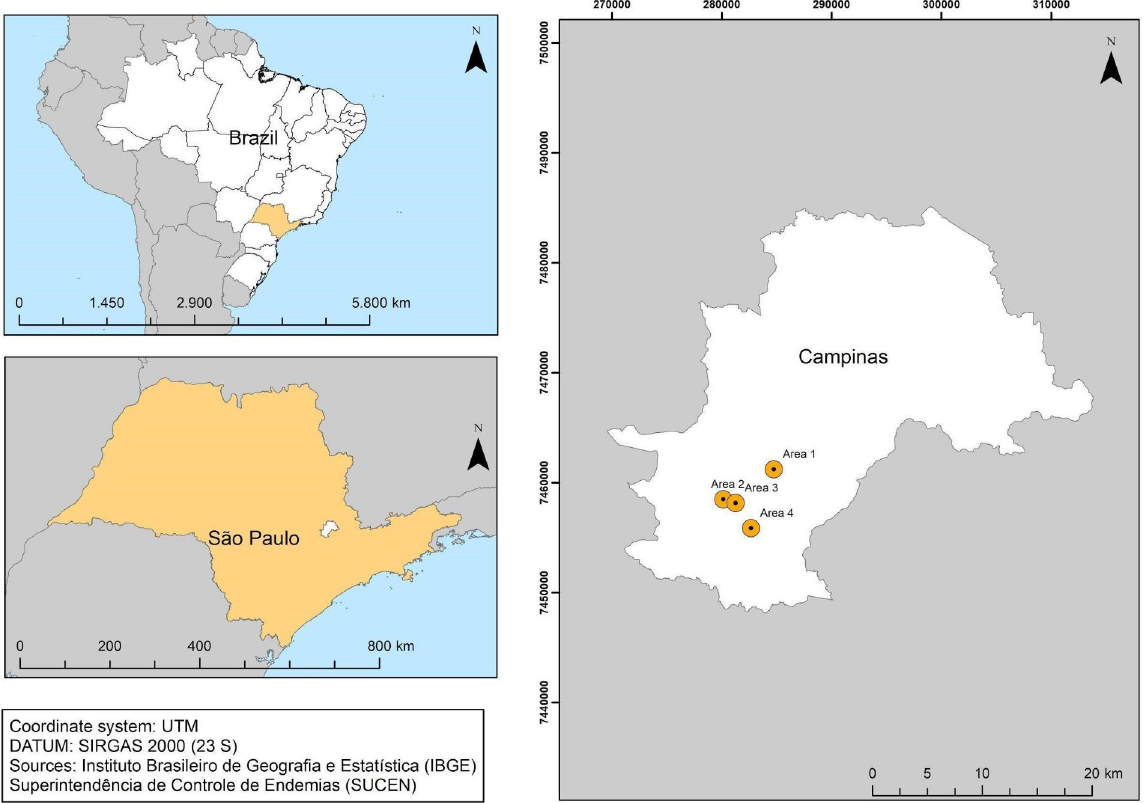
Fig 2. City of Campinas with neighborhoods used in the